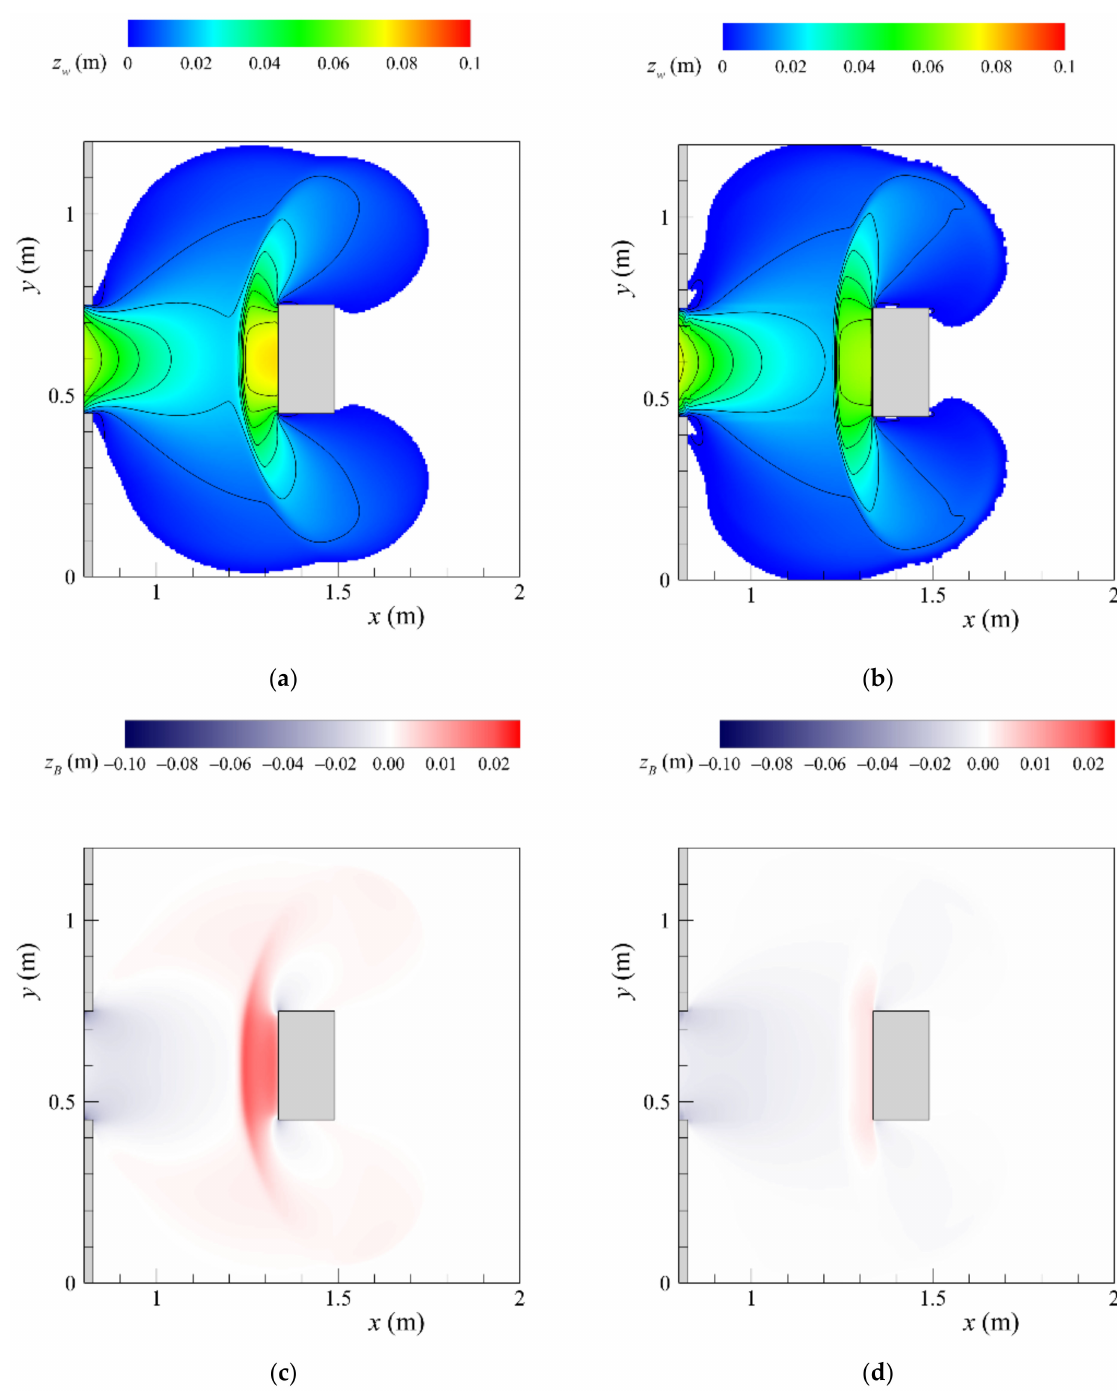
Figure 8. Results for PVC particles d = 5 × 10 − 4 m at t = 1.0 s: ( a ) free-surface elevation predicted by the SVEM; ( b ) free-surface elevation predicted by the TPM; ( c ) bottom elevation predicted by the SVEM; ( d ) bottom elevation predicted by the